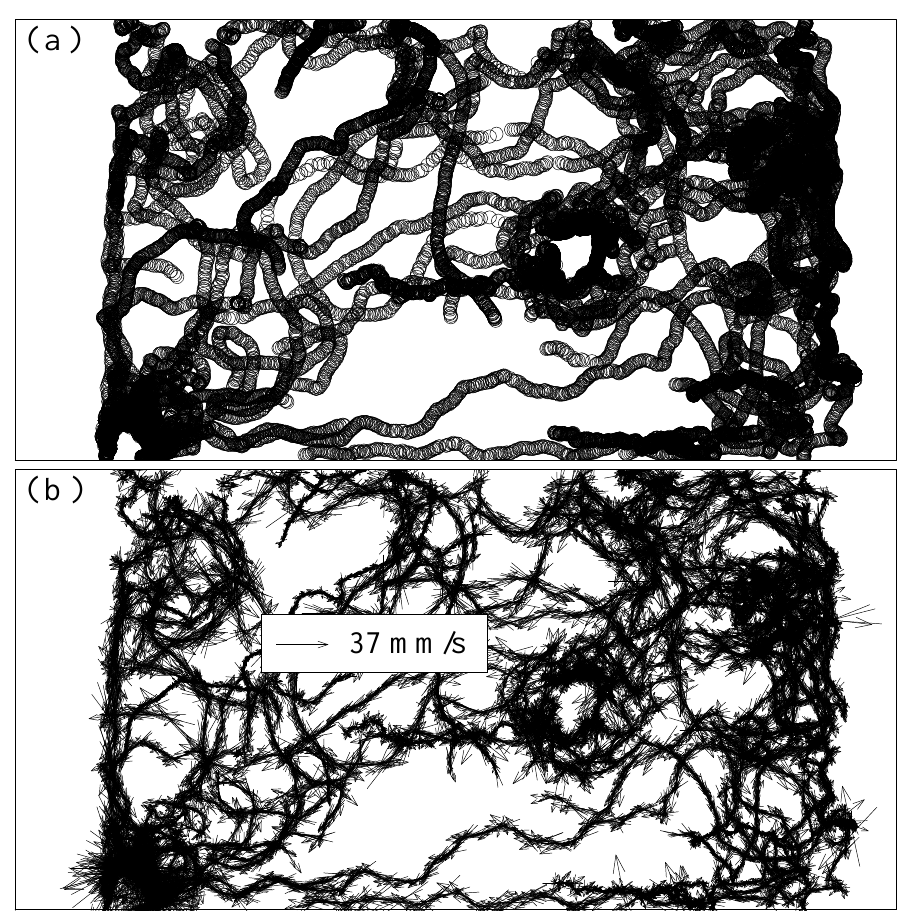
Figure 8. Esemble image tracking results: overlapped ant positions (a) and speed vectors (b) in case #2, 2nd group (view area: 418×209 mm 2